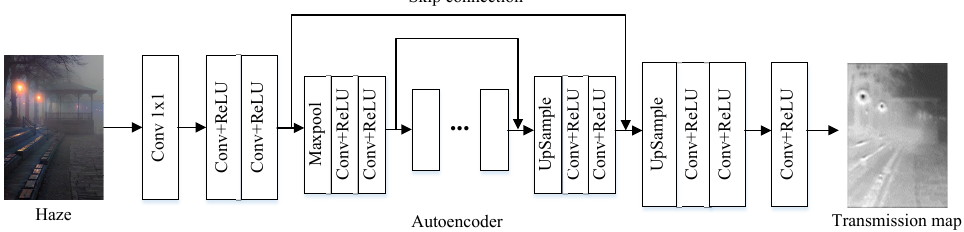
Figure 4. The architecture of transmission computing network. It contains one convolutional layer and an autoencoder network with skip connections.